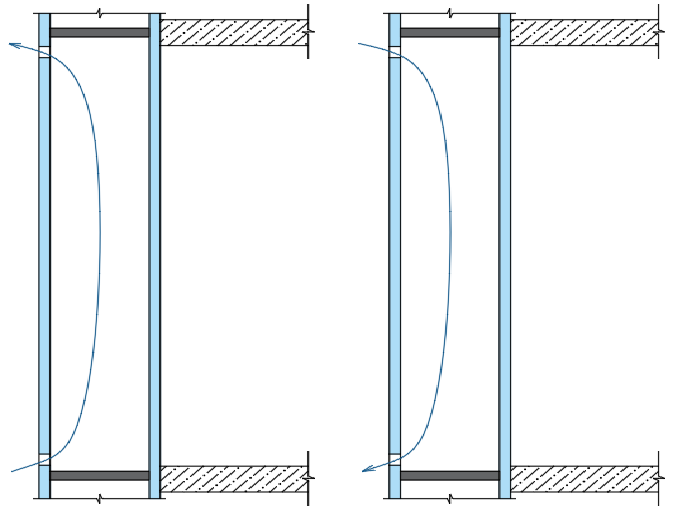
Figure 10. Facades with ventilated air gap by external air (external air curtain).